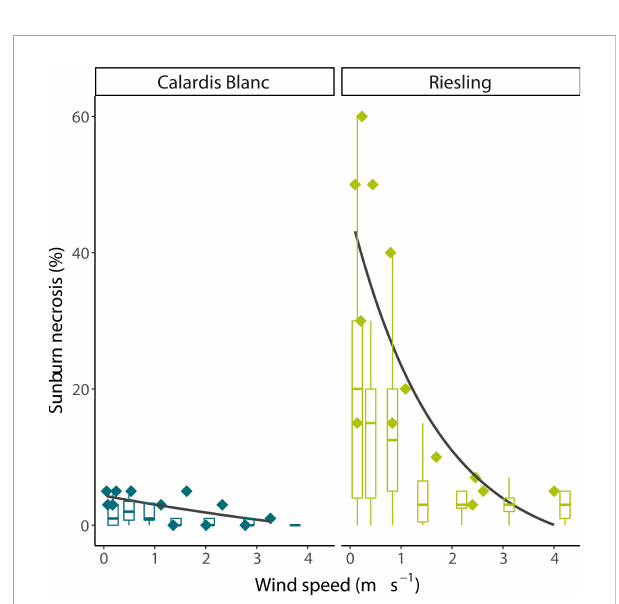
FIGURE 6 Effect of wind speed on sunburn necrosis severity of Calardis Blanc and Riesling grape clusters in a vineyard at Geisenheim. Box plots represent all clusters in the canopy, symbols represent marked, formerly shaded clusters. Solid lines represent logarithmic fi ts of necrosis severity of marked clusters vs. wind